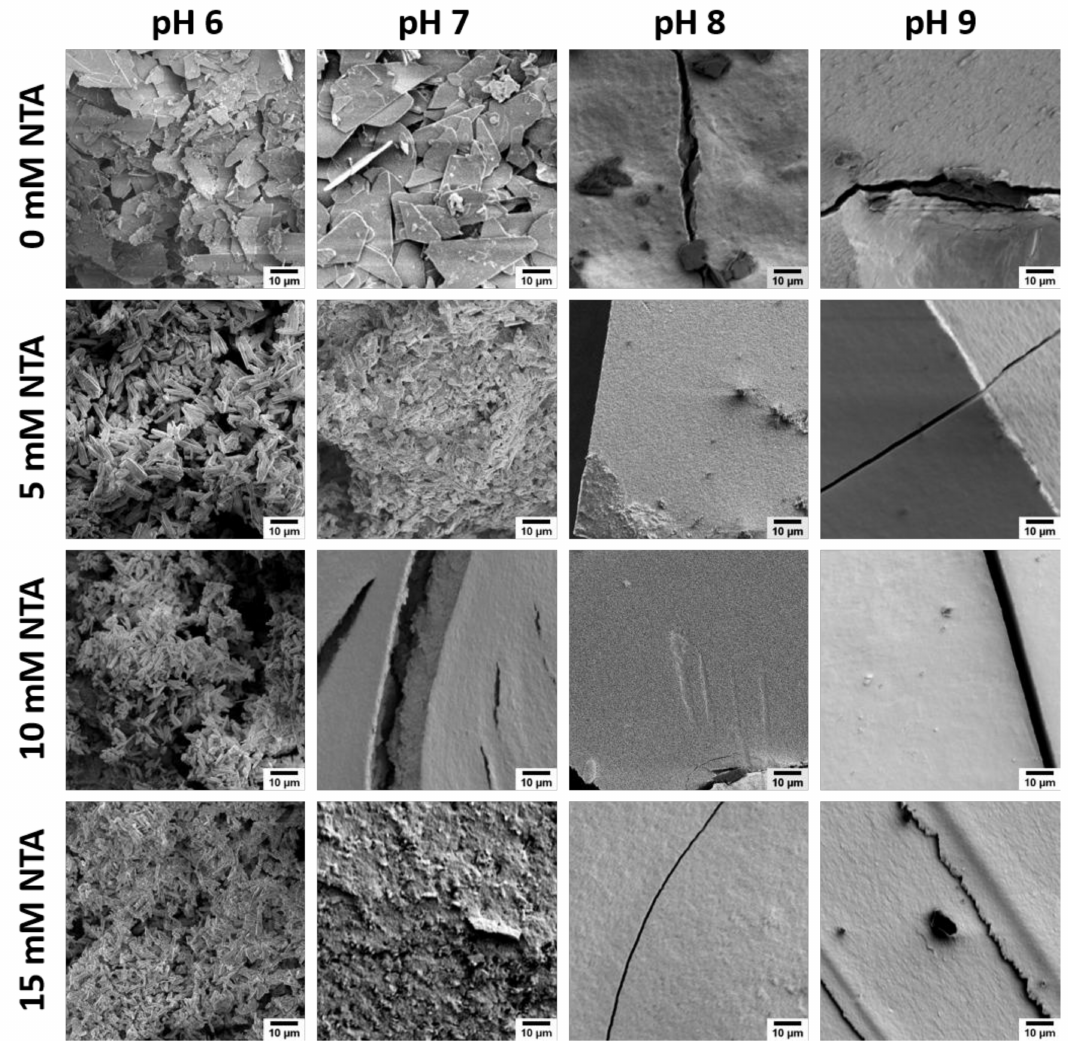
Figure 1. Representative scanning electron microscopy (SEM) images of CP precipitated in the absence (control samples) and presence of NTA at different pH. Higher magnification images of the aggregated blocks are shown in the Appendix A, Figure